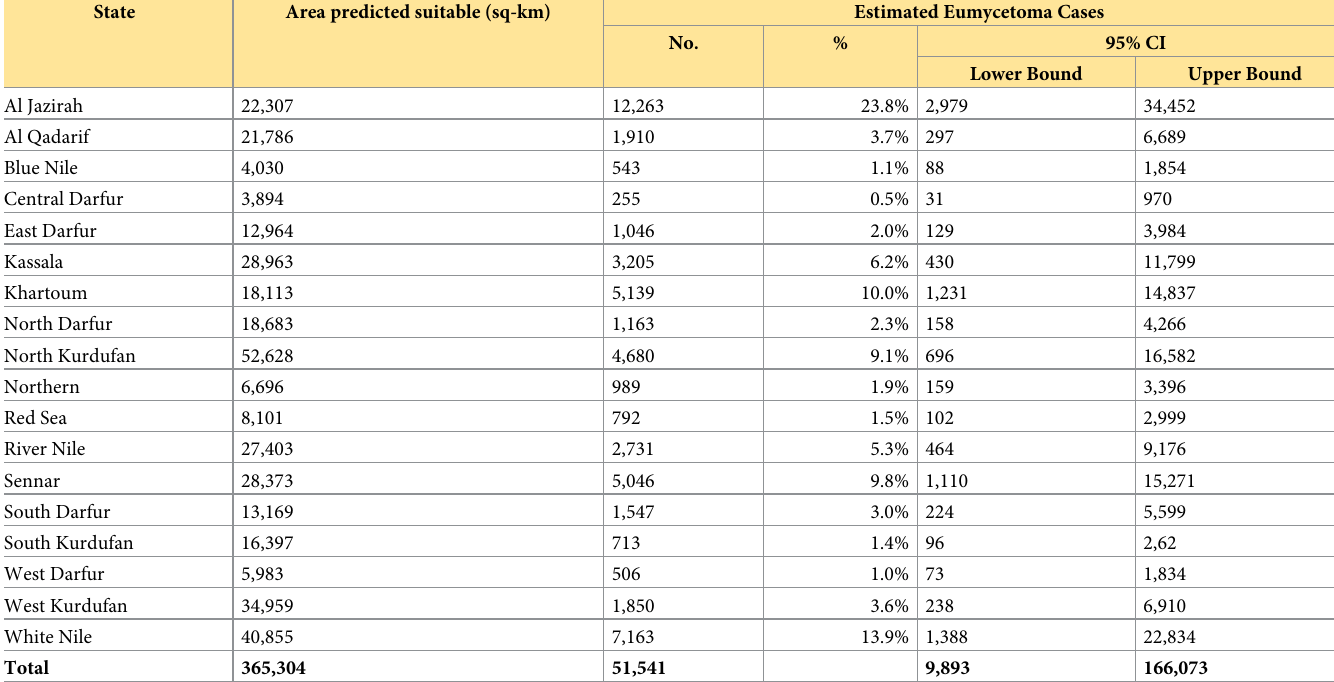
Table 1. Estimation of eumycetoma cases by state in Sudan between 1991 and 2018.